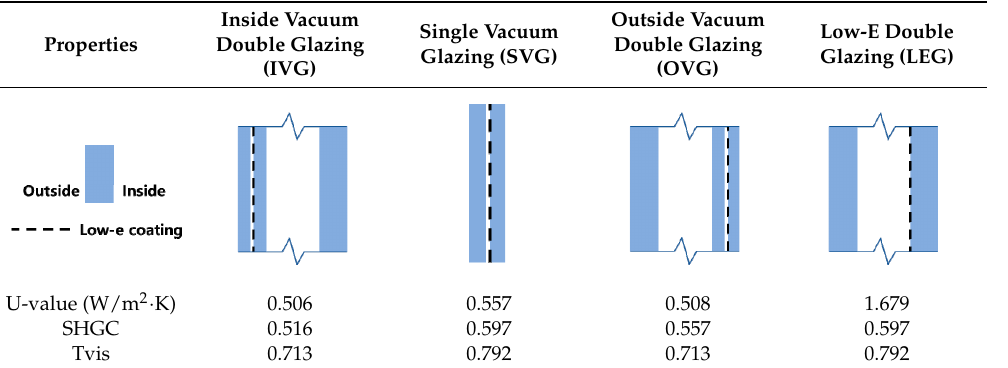
Table 3. Calculated thermal and optical properties of tested glazing systems.